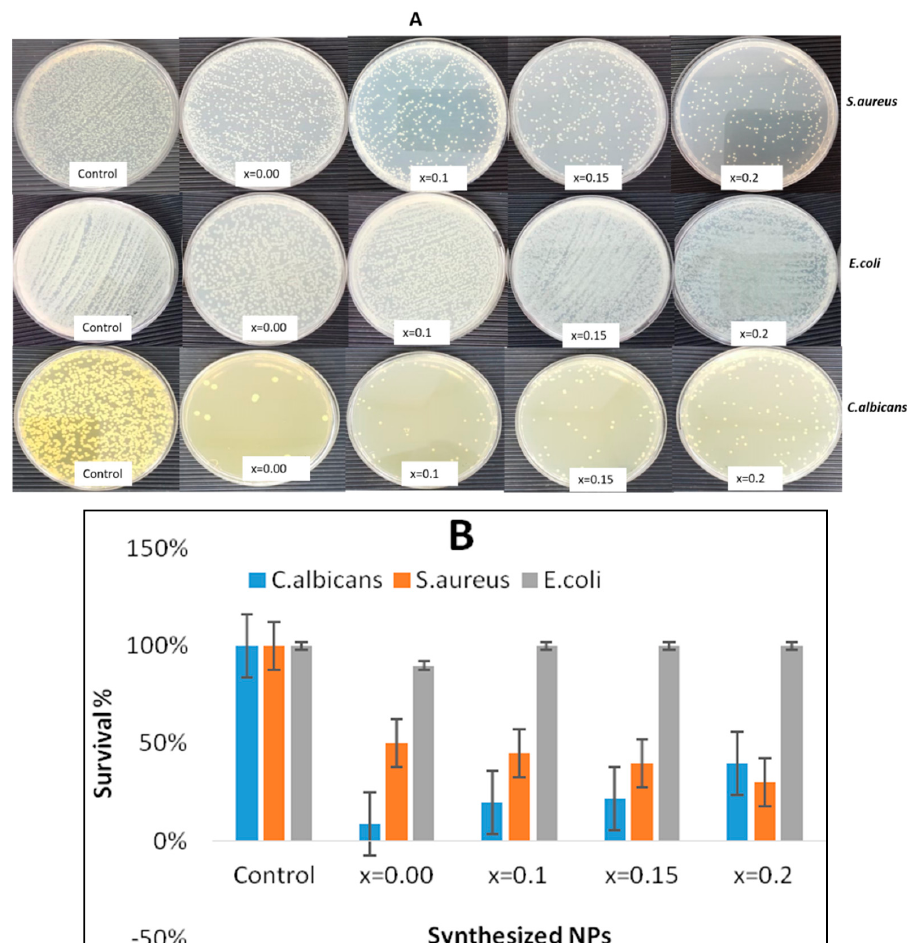
Figure 5. ( A ) Culture plates and ( B ) Survival rate (%), of treated microbes with 1 mg/mL of CoNd x Fe 2 − x O 4 (0.0 ≤ x ≤ 0.2) NPs, Control; untreated cells.